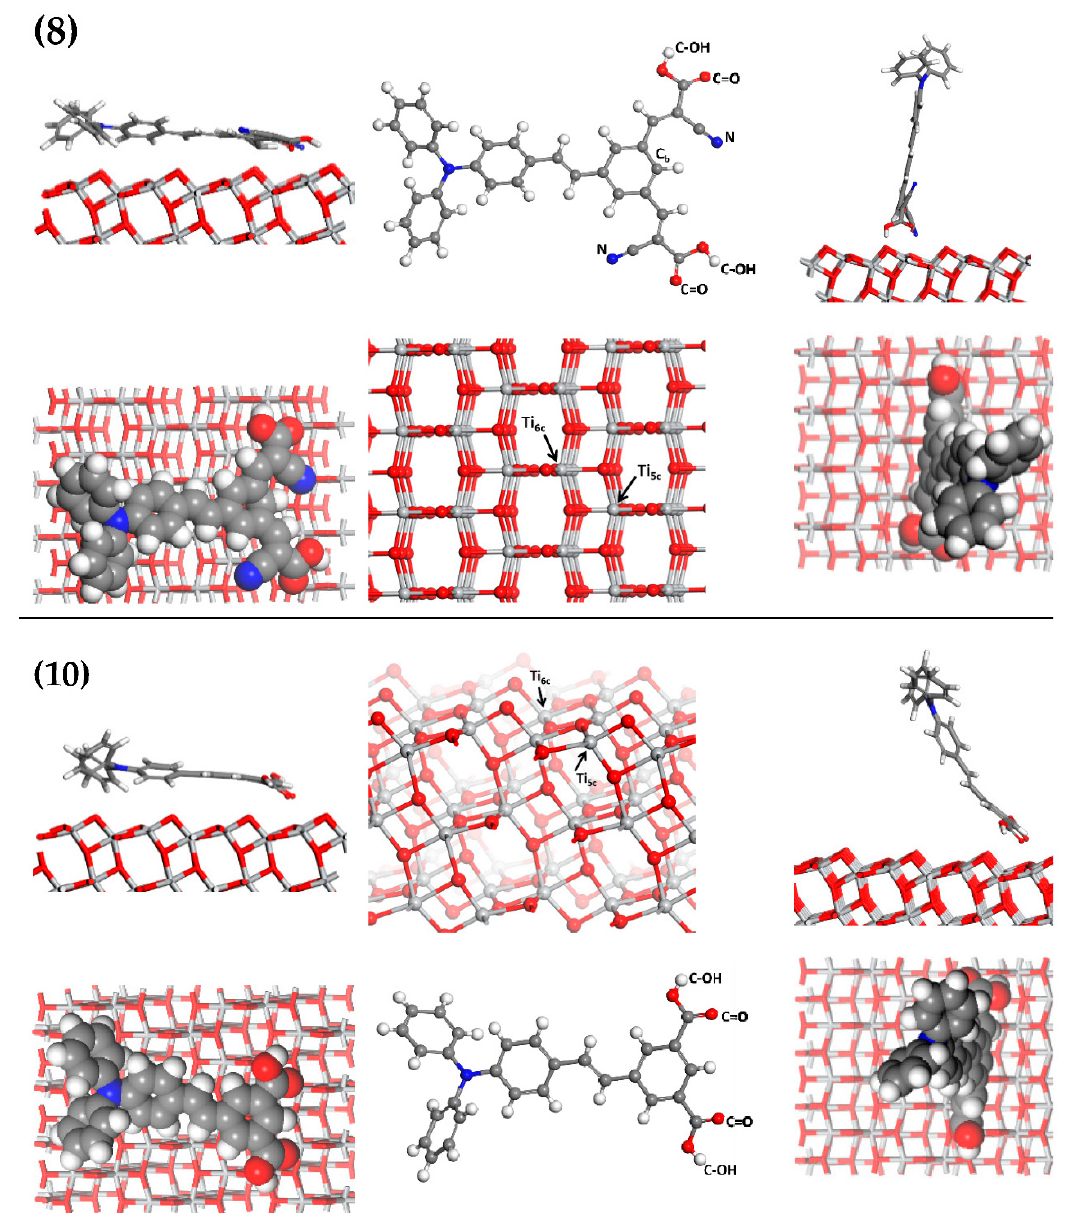
Figure 4. Atomistic modelling results of dyes ( 8 )—top row and ( 10 )—bottom row, oriented horizontally (left column) and vertically (right column) showing cross-sectional and plan views relative to the TiO 2 surface. Central column shows dyes and the labels of specific atoms involved in dye / surface interactions, plus cross-sectional and plan views of TiO 2 . Ti 5c and Ti 6c refer to five- and six-coordinated Ti, respectively. Color scheme: O—red; Ti—light grey; C—dark grey; N—blue; H— white.